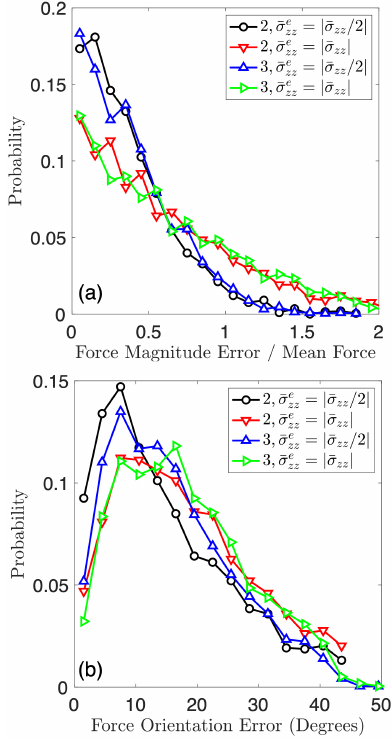
Figure 2. (a) Normalized inferred force magnitude errors. (b) Inferred force orientation